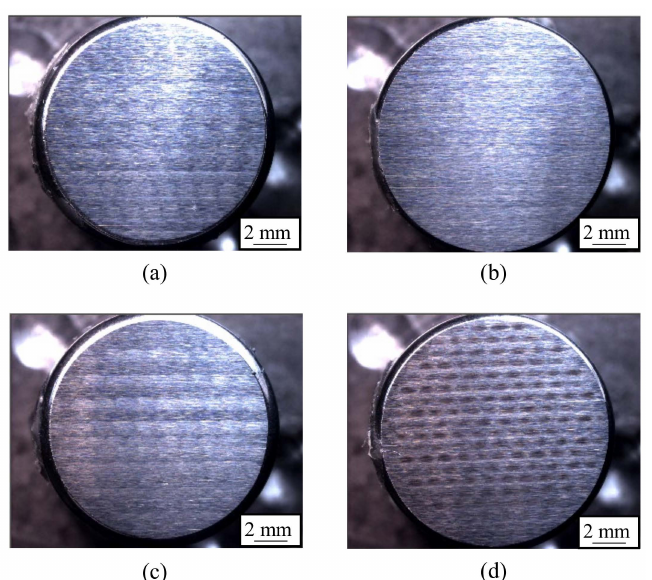
Figure 4. Images of the machined surface after grinding with cutting fluid at different temperatures: ( a ) 5 ◦ C; ( b ) 10 ◦ C; ( c ) 15 ◦ C; and ( d ) room